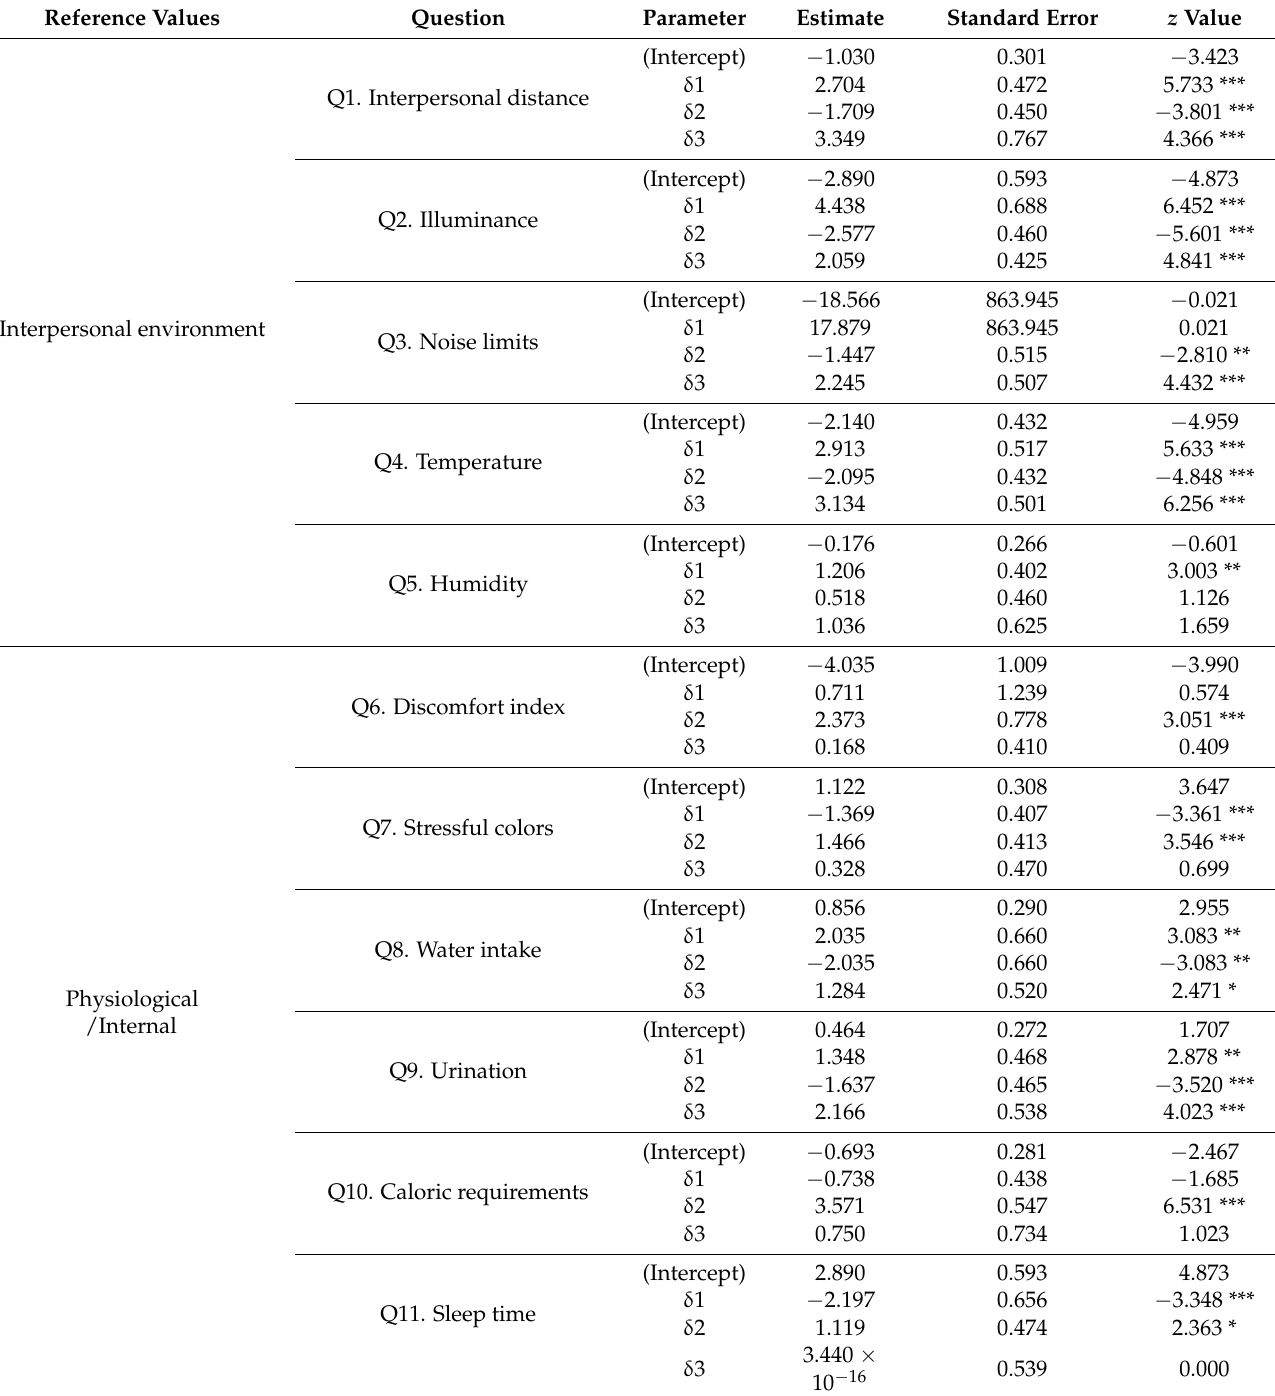
Table 2. Parameter estimates for each